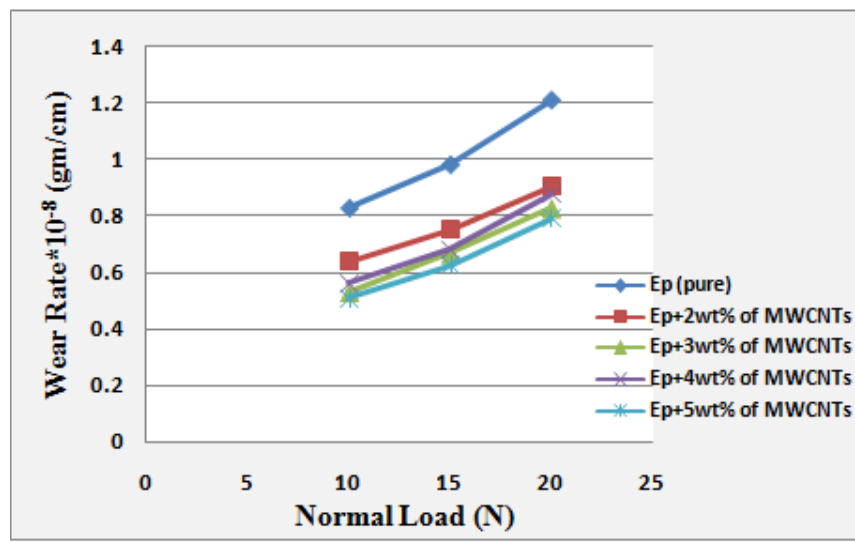
Fig. 4: The effect of applied load on wear rate for Ep/MWCNTs nanocomposites in natural condition.